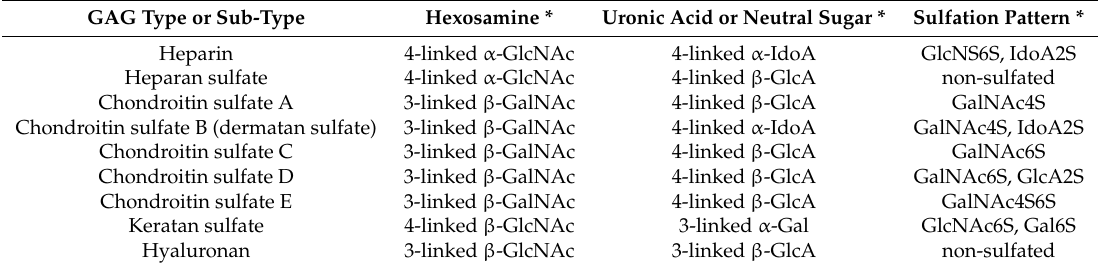
Table 1. Commonest monosaccharides and sulfation patterns of the different (sub)classes of glycosaminoglycans (GAGs).